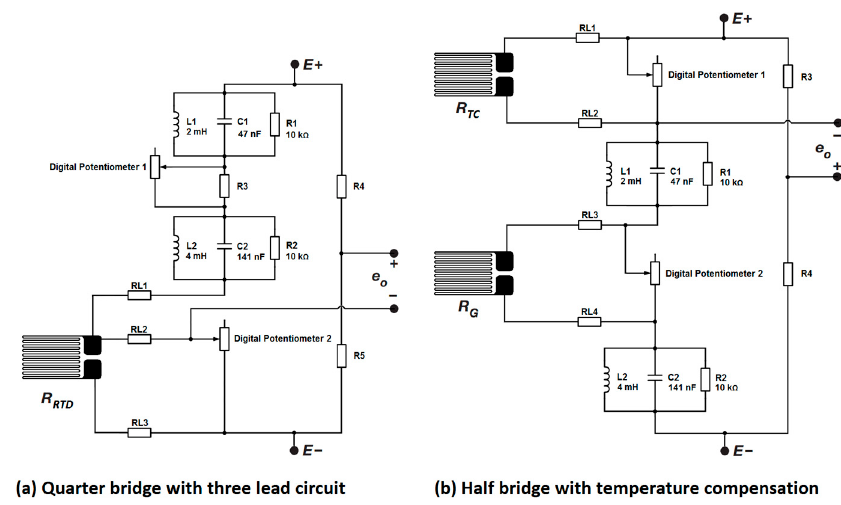
Figure 9. Circuit schematic of the Wheatstone bridge arrangements for ( a ) the temperature sensor and ( b ) the stress sensor. Digital potentiometers 1 and 2 are used to balance the resistive component of the bridge, while a dual parallel RCL arrangement is used to balance the imaginary component of the bridge.